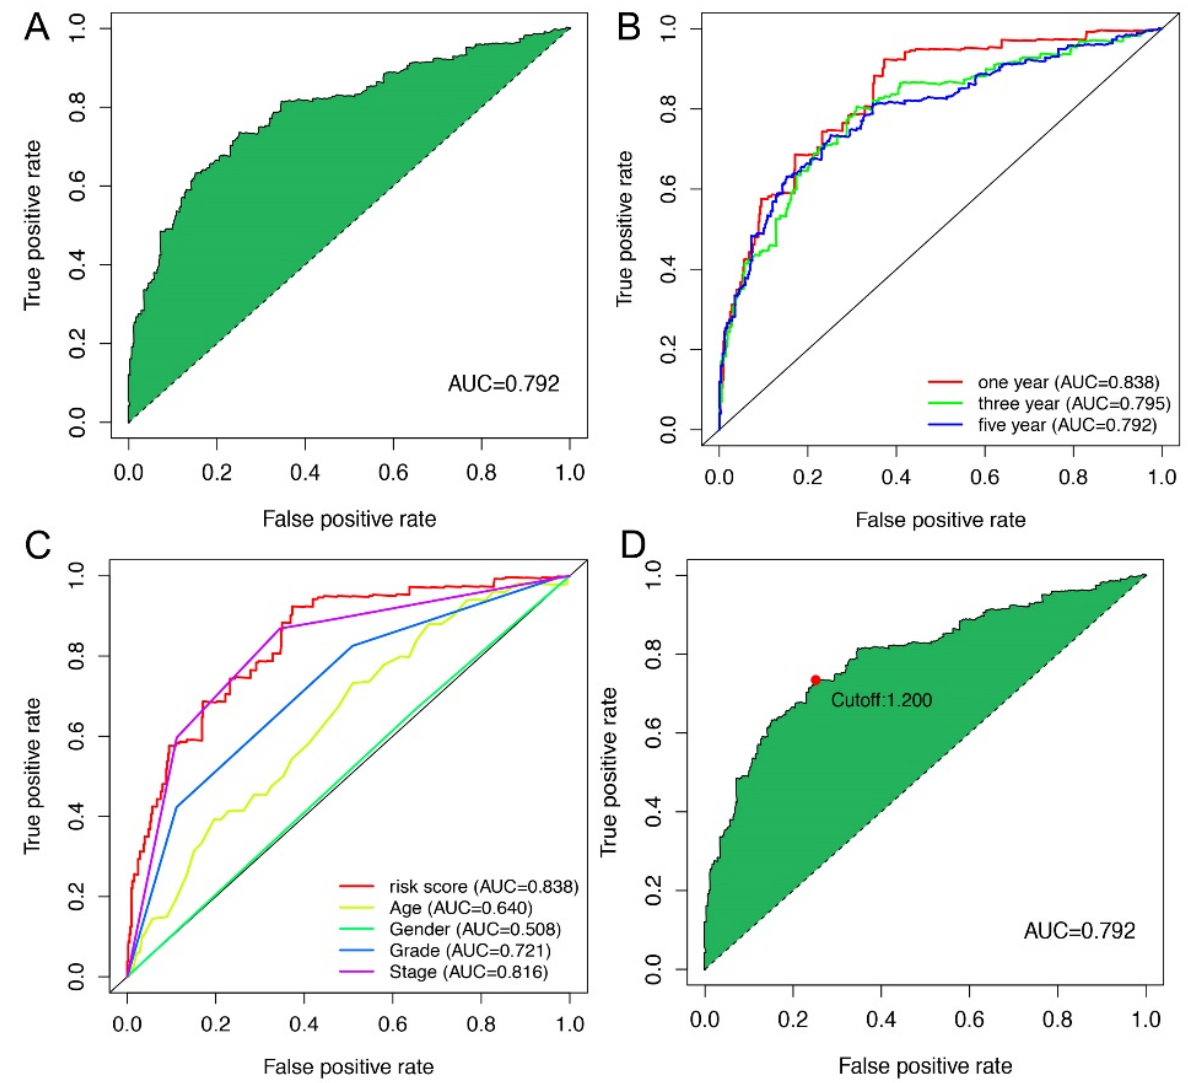
Figure 2. Construction of a risk assessment model using DEirlncRNA pairs. ( A ) The ROC of the optimal DEirlncRNA pair model. ( B ) The 1-, 3-, and 5-year ROC of the optimal model suggested that all AUC values were over 0.792. ( C ) A comparison of 5-year ROC curves with other common clinical characteristics showed the superiority of the riskScore. ( D ) RiskScore for 539 patients with KIRC; the maximum inflection point is the cut-off point obtained by the AIC.